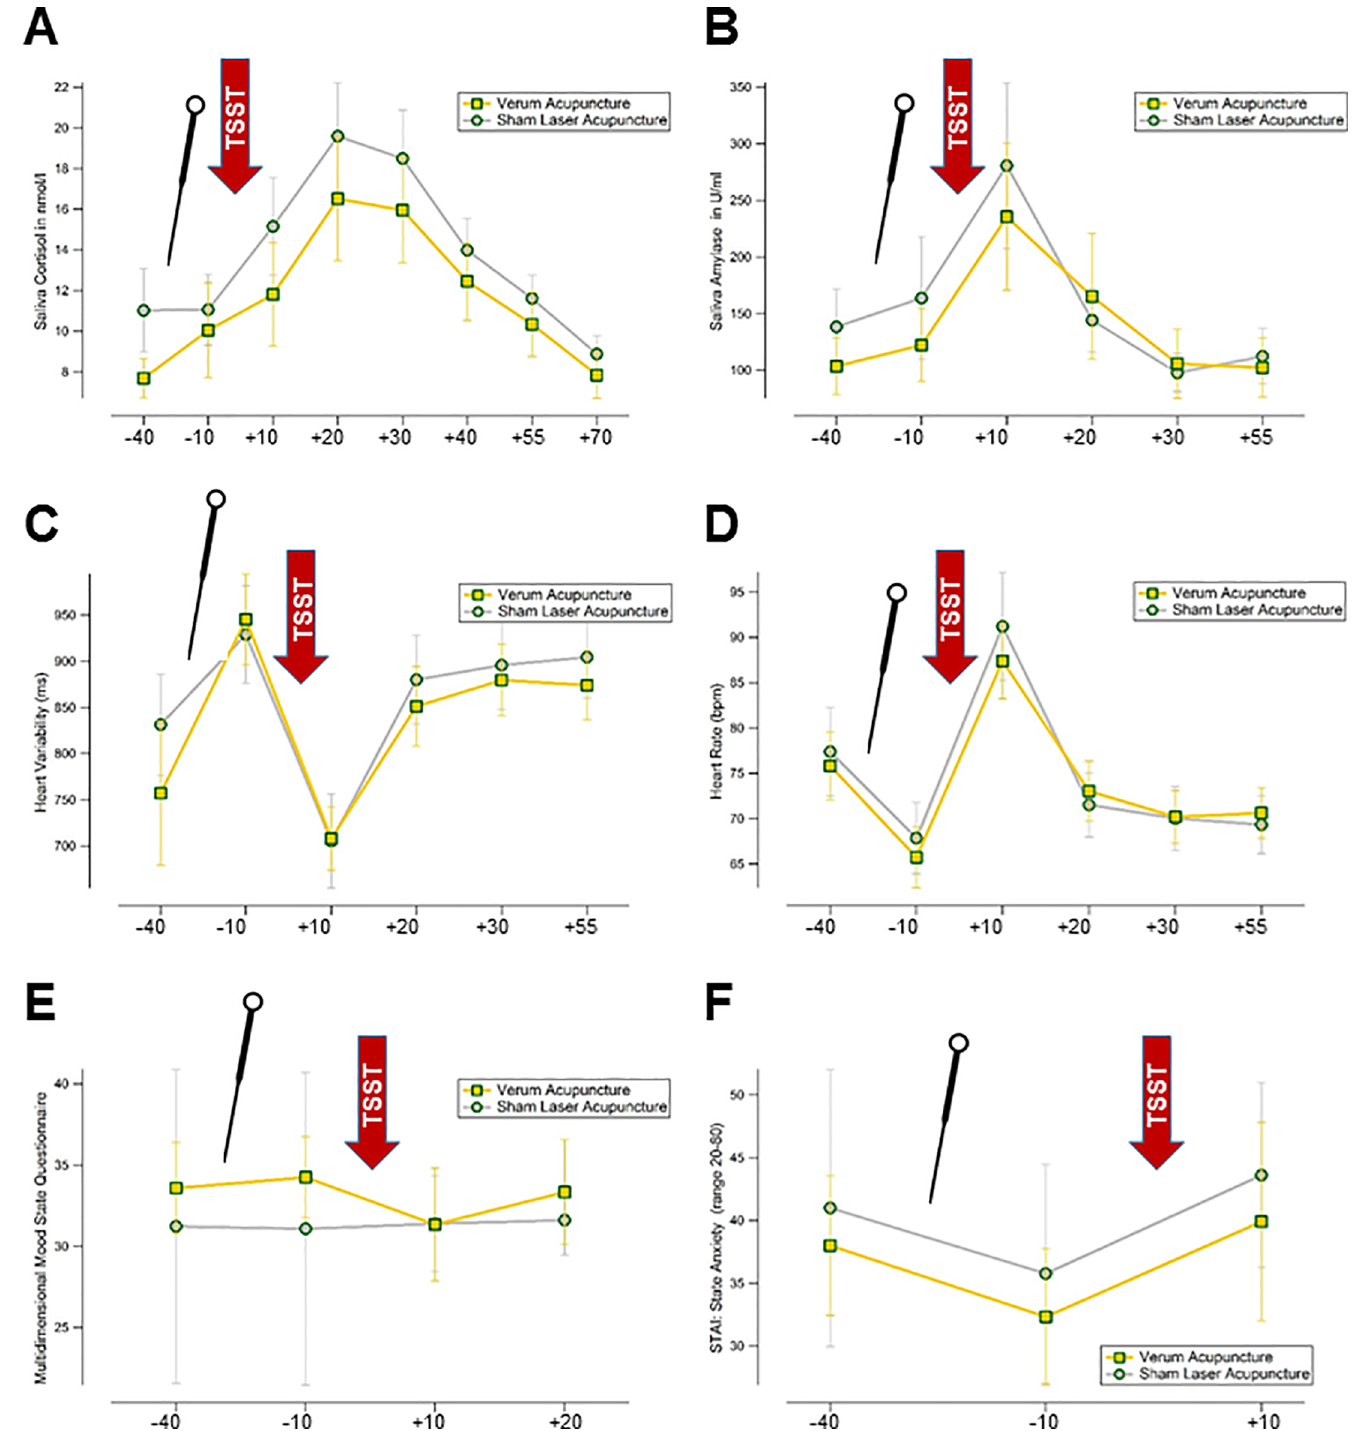
Fig 2. Describes the physiological and psychological effects of acupuncture on test anxiety, i.e. the time-course of (A) saliva cortisol and (B) saliva amylase. (C) and (D) depict the ECG analysis with respect to heart rate and heart rate variability. (D) is the score of the MDMF and (F) the scores of the STAI-state anxiety. The red flashes labelled TSST indicate the occurrence of the stress test, the acupuncture needle depicts the time of intervention (30 minutes prior to the TSST). The times are as follows: -40 and -10 minutes previous to the TSST, and +10, +20, +30, +40, +55, +70 minutes thereafter (as suggested by Kirschbaum et al., 1993).